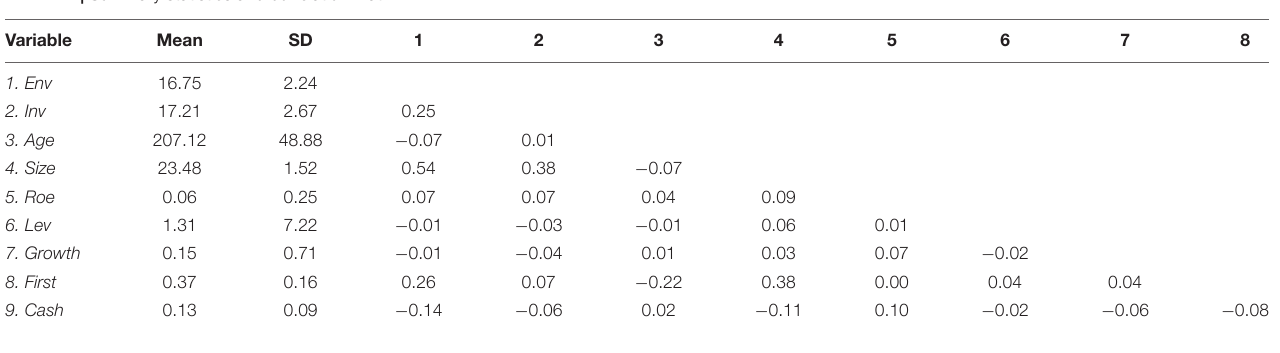
TABLE 1 | Summary statistics and correlation matrix.